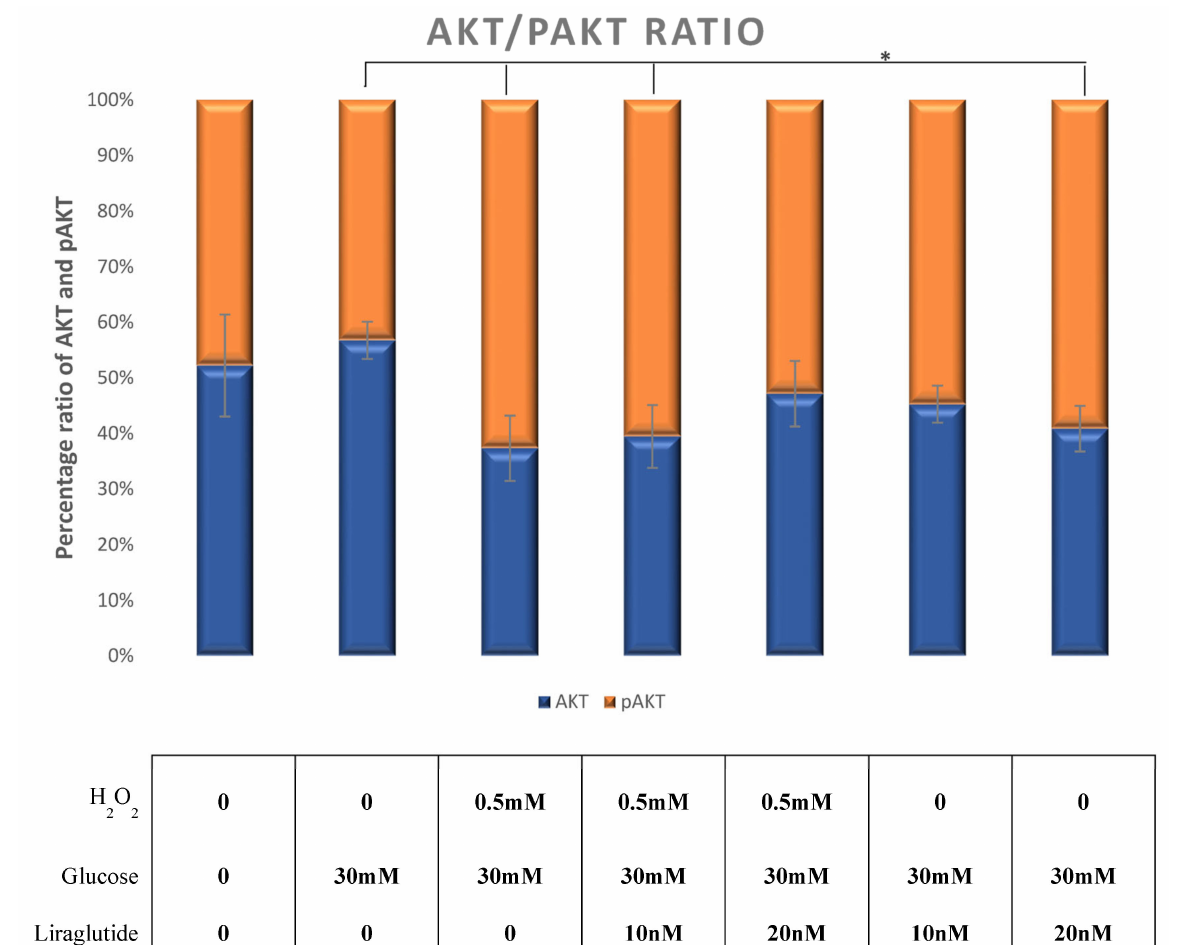
Figure 7. Ratio of pAKT/AKT molecules calculated from protein expression in the LLC-PK1-treated cell line (control vs. HG30 and HG30/H 2 O 2 ; HG30 vs. HG30/Lira10 and HG30/Lira 20; HG30/H 2 O 2 vs. HG30/H 2 O 2 /Lira10 and HG30/H 2 O 2 /Lira 20) determined by Western blot. The data are shown as the means ± SD (standard deviation) from three independent biological replicates. One-way ANOVA F(6,20) = 4.659, p = 8.34 × 10 − 3 with Tukey HSD post hoc test; * p < 0.05. Values underneath the x axis represent the amount of compound added in the experiment, and 0 represents that the compound was not added. Protein expression, pig proximal tubule cell line (LLC-PK1), HG (1.5 mM, 30 mM), H 2 O 2 (0.5 mM), Liraglutide (10 nM, 20 nM). A decrease in GSK3 β protein levels was demonstrated in HG30/H 2 O 2 -treated cells compared to those treated only with HG30. GSK3 β protein levels were increased in cells treated with HG30/H 2 O 2 /Lira10 and 20 compared to those treated with HG30/H 2 O 2 ( p < 0.01), as shown in Figure